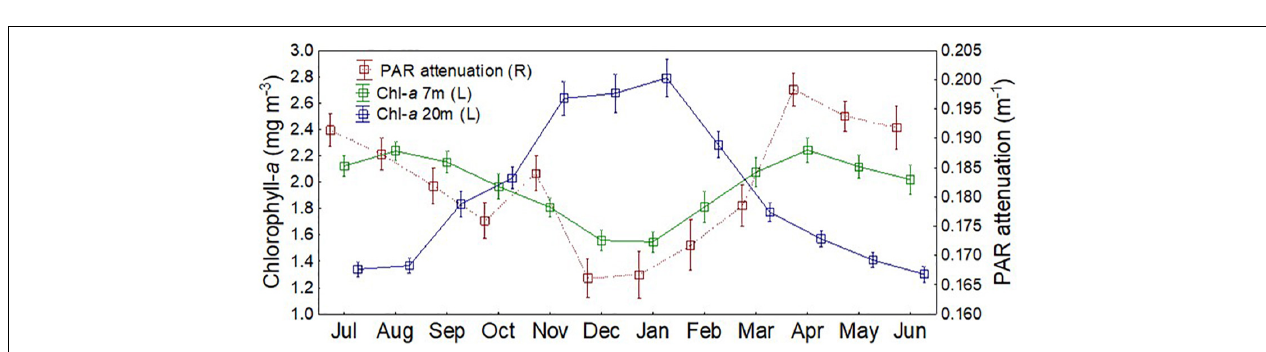
FIGURE 8 | Chl- a biomass (left vertical axis) and attenuation of photosynthetic active radiation (PAR) (right vertical axis) (monthly medians and quartiles), from Integrating Natural Fluorometers at the outer Firth mooring site at upper water column (7 m) and mid-water column (20) depths, determined over 2005–2015. For reference, Spring = September to November, Summer = December to February, Autumn = March to May, Winter = June to